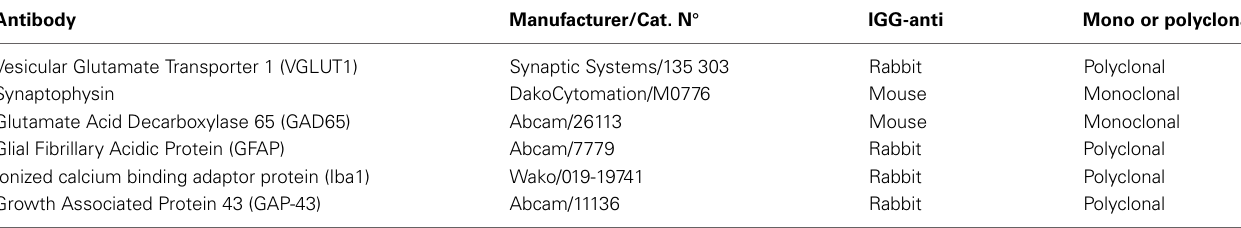
Table 3 | Primary antibodies used for